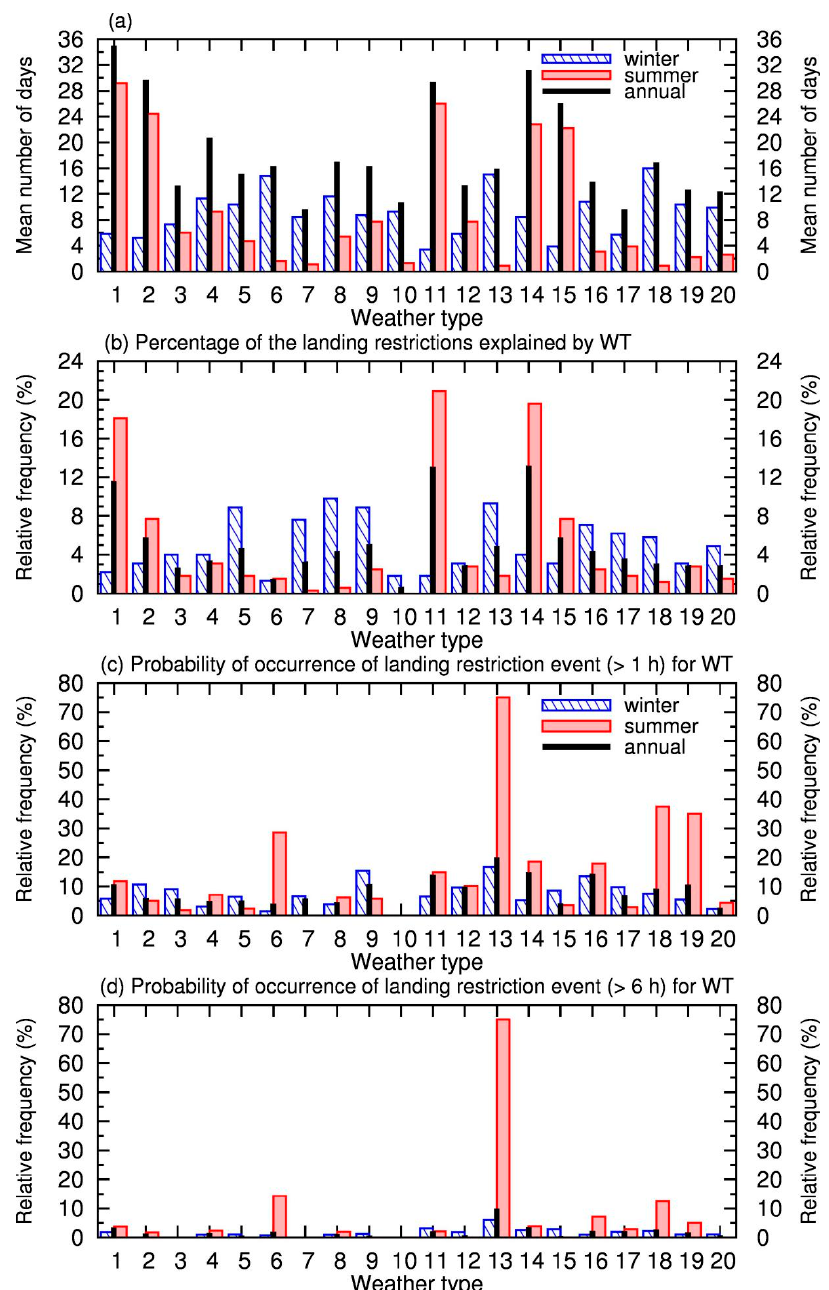
Figure 6. ( a ) Mean number of days of occurrence (in percent) by weather type (from WT1 to WT20) for wintertime (blue), summertime (red) and annual (black) periods. ( b ) Percentage of the total landing restrictions occurring for each WT. Probability of occurrence of a landing restriction event at MIA with a duration of more than ( c ) 1 h and ( d ) 6 h, when a certain WT occurs.